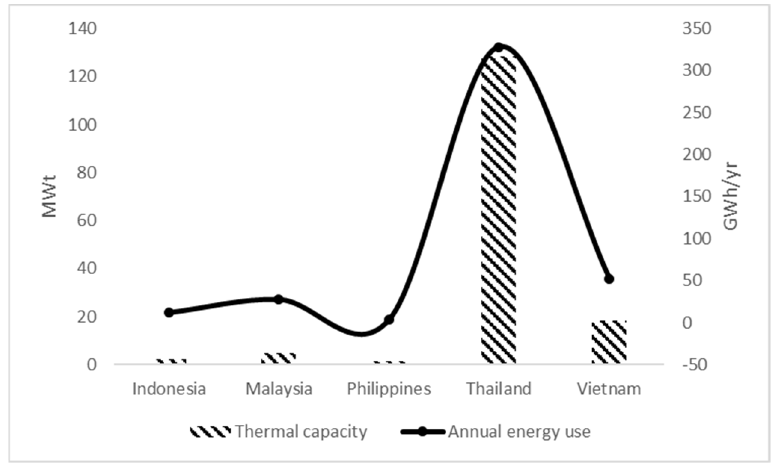
Figure 4. Comparison of thermal capacity and annual energy use in the countries of Southeast Asia.